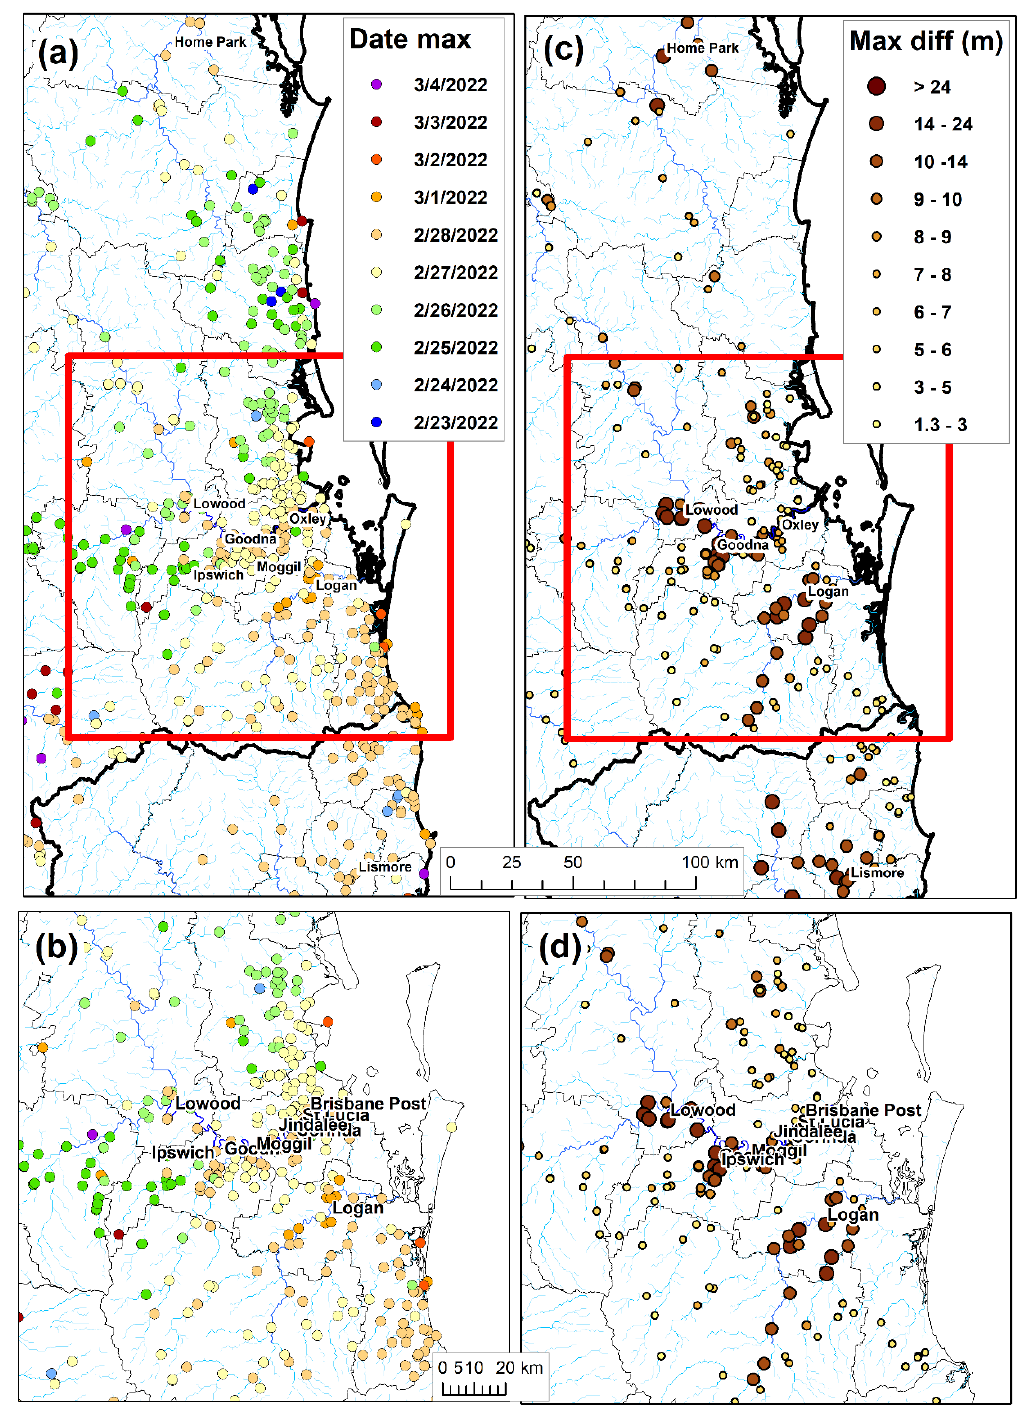
Figure 2. Australian Bureau of Meteorology (BoM) river gauge stations: Date of maximum river height ( a , b ), and the difference (m) between maximum river height and the pre-flood height ( c , d ). The temporal changes in river height are shown in Figure 3 for the labeled stations. The station of Home Park is located on the Mary River, north of Gympie. The rivers were derived from the global Hydrosheds dataset [44]. The extent of the maps in ( b , d ) is shown by a red line in ( a , c ).